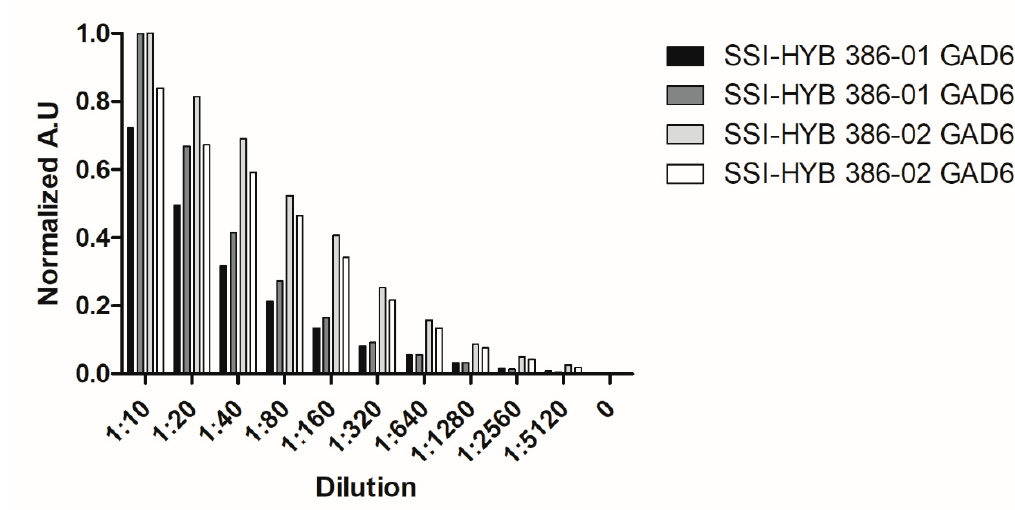
Figure 9. Reactivity of SSI-HYBs analyzed by enzyme-linked immunosorbent assay.